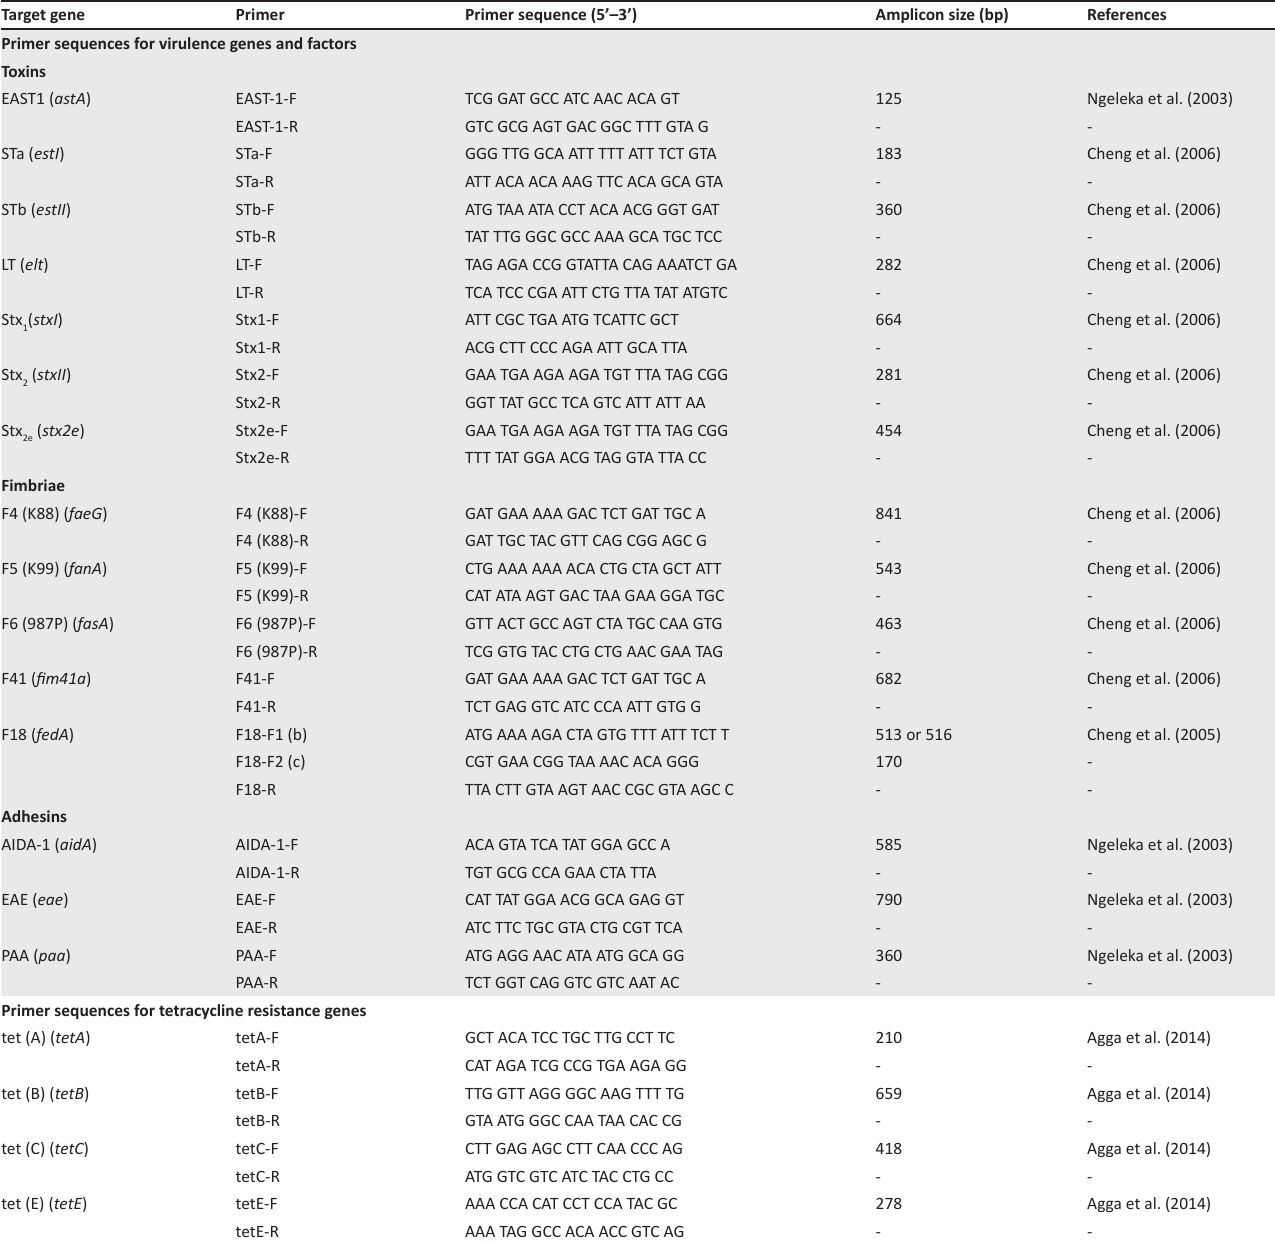
TABLE 2: Primer sequences and amplicon sizes used for polymerase chain reaction detection of virulence genes, virulence factors and tetracycline resistance genes. Target gene